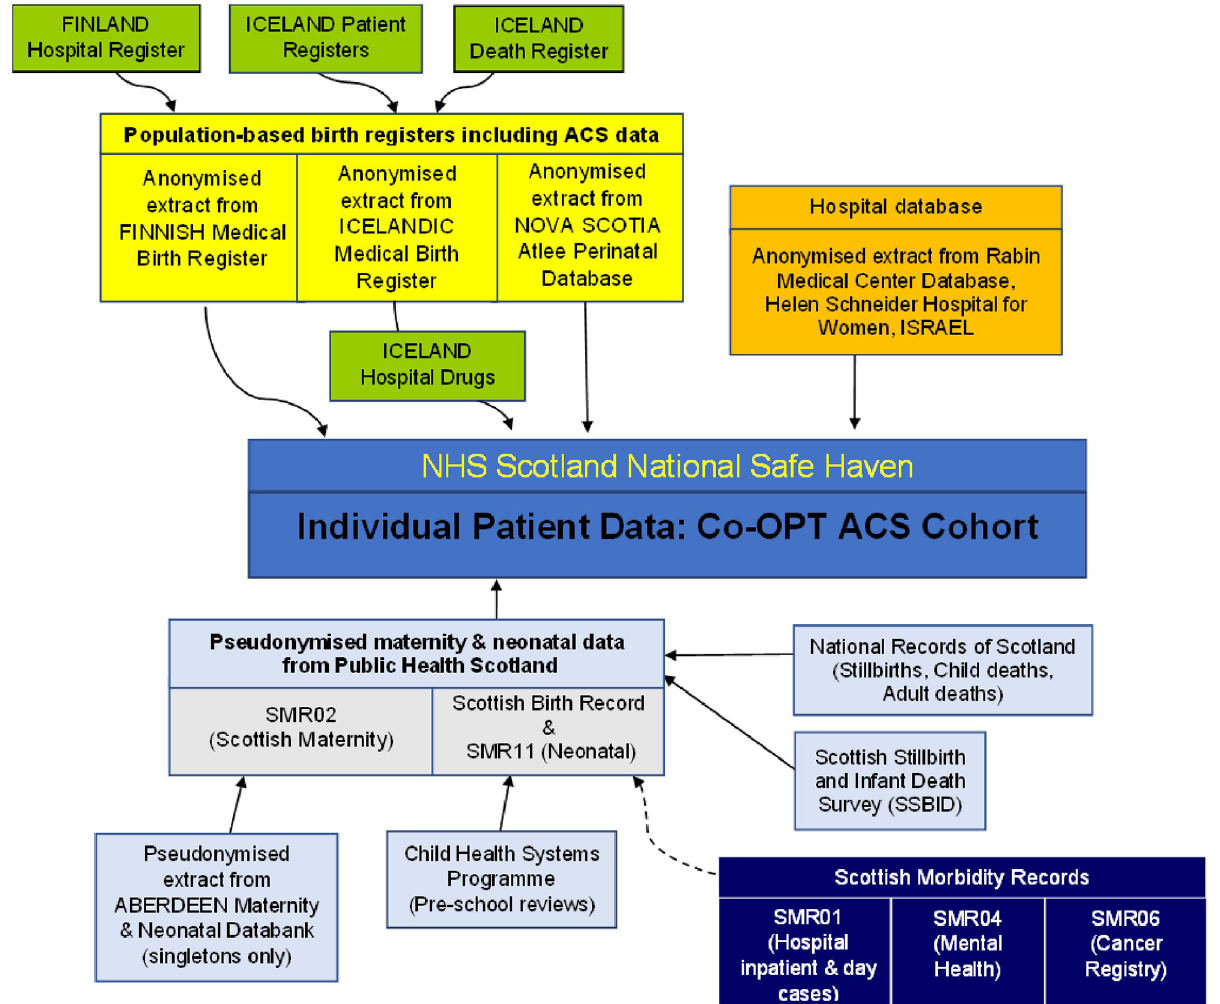
Fig 1. Data flow diagram for Co-OPT ACS cohort. ACS = Antenatal corticosteroids. NHS = National Health Service. SMR02 = Maternity Inpatient and Day Case Scottish Morbidity Records. SMR11 = Neonatal Scottish Morbidity Records.